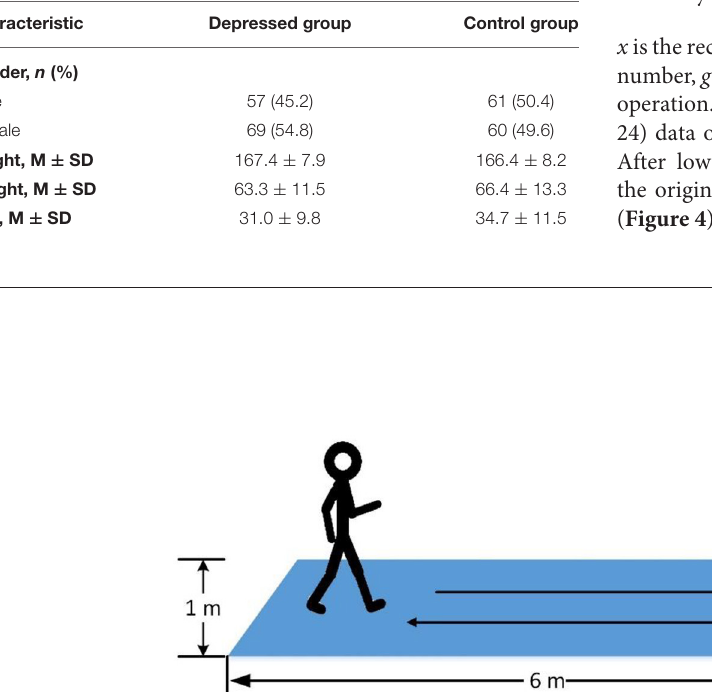
TABLE 1 | Demographic characteristics of participants.